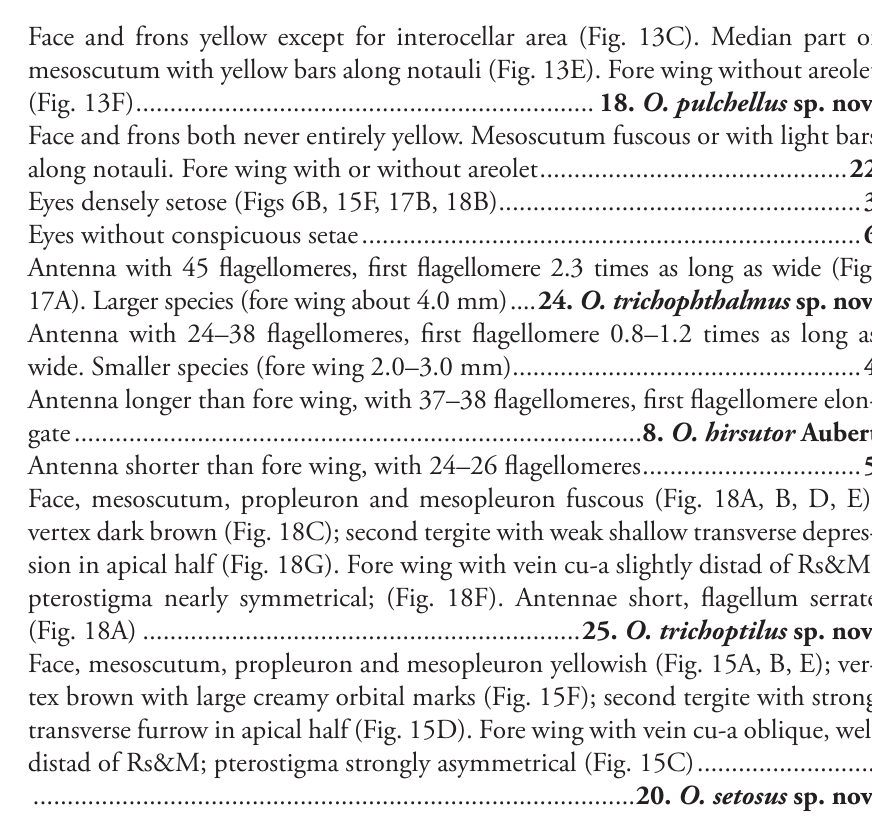
Key to Orthocentrus species occurring in South Korea (Females only) 1 Face and frons yellow except for interocellar area (Fig. 13C). Median part of mesoscutum with yellow bars along notauli (Fig. 13E). Fore wing without areolet (Fig. 13F) ................................................................... 18. O. pulchellus sp. nov. Face and frons both never entirely yellow. Mesoscutum fuscous or with light bars along notauli. Fore wing with or without areolet ............................................. 22 Eyes densely setose (Figs 6B, 15F, 17B, 18B) ..................................................... 3 Eyes without conspicuous setae ......................................................................... 6 Antenna with 45 flagellomeres, first flagellomere 2.3 times as long as wide (Fig. 17A). Larger species (fore wing about 4.0 mm) .... 24. O. trichophthalmus sp. nov. Antenna with 24–38 flagellomeres, first flagellomere 0.8–1.2 times as long as Antenna longer than fore wing, with 37–38 flagellomeres, first flagellomere elon-